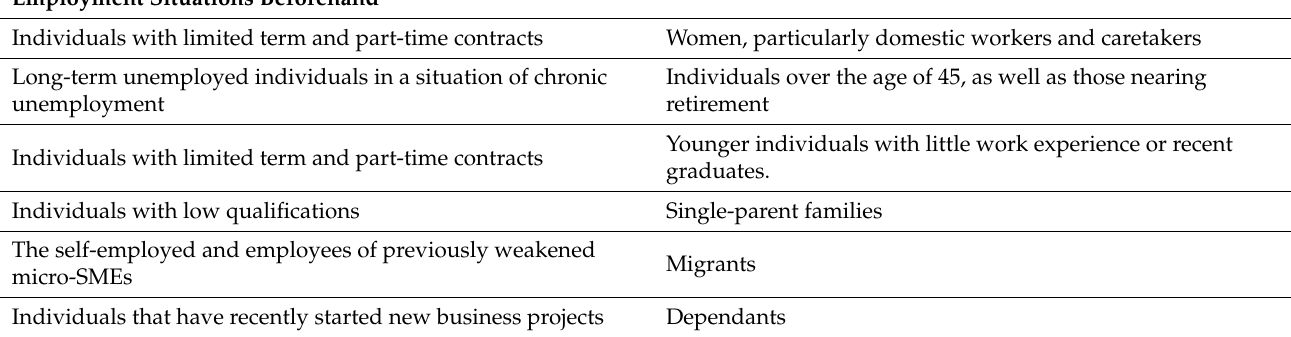
Table 1. Priority sub-groups depending on their vulnerability to COVID-19’s impact (compilation based on the information collected from our fieldwork).